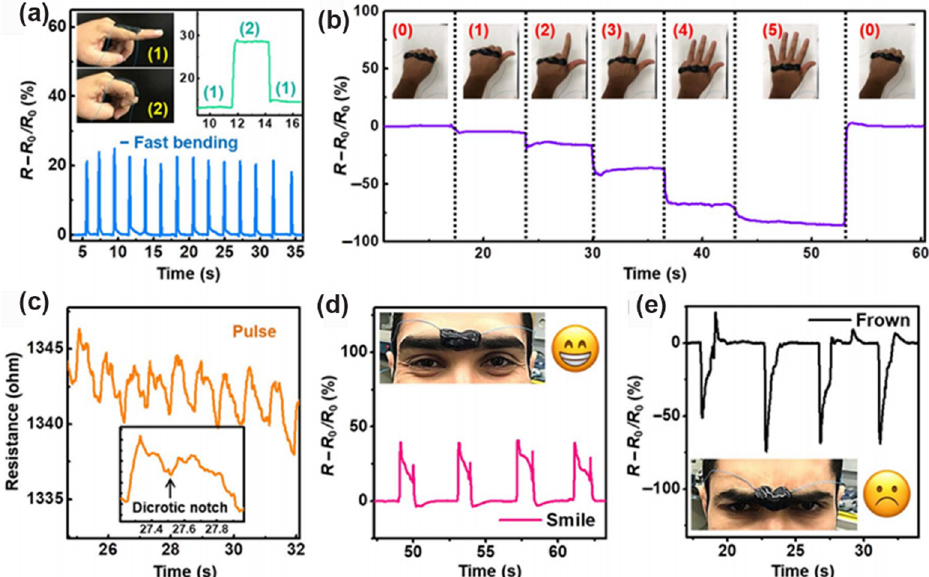
Figure 12. Resistance changes of MXene/PVA hydrogel in response to ( a ) finger bending, ( b ) different hand gestures, ( c ) human pulse, insert showing a typical dicrotic notch, and ( d , e ) facial expressions. Reproduced with permission from ref. [70]. Copyright 2018, the American Association for the Advancement of Science.